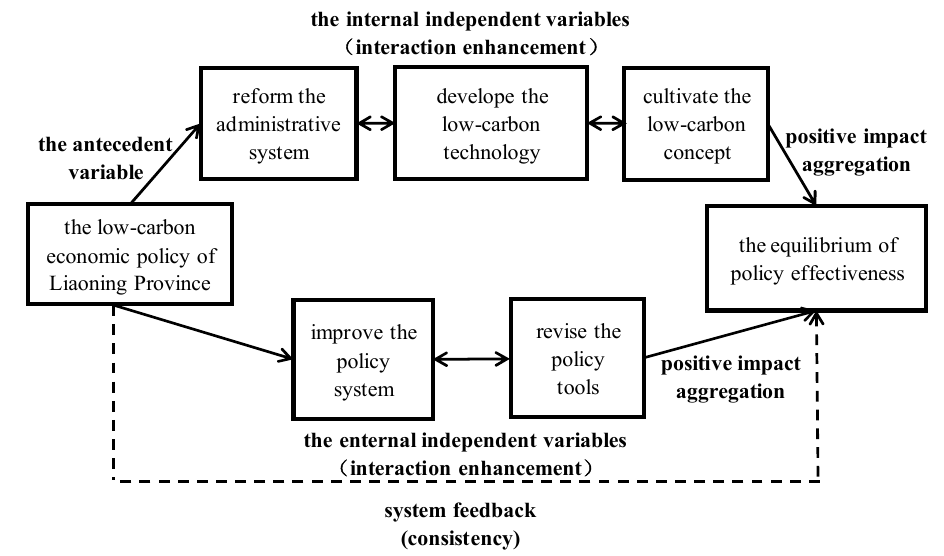
is weakened, thus maximizing the effectiveness of the limited combined resources. For further detail on the ideal state of multi-factor linkage of policy effectiveness in a low-carbon economy, we refer to Figure 3.